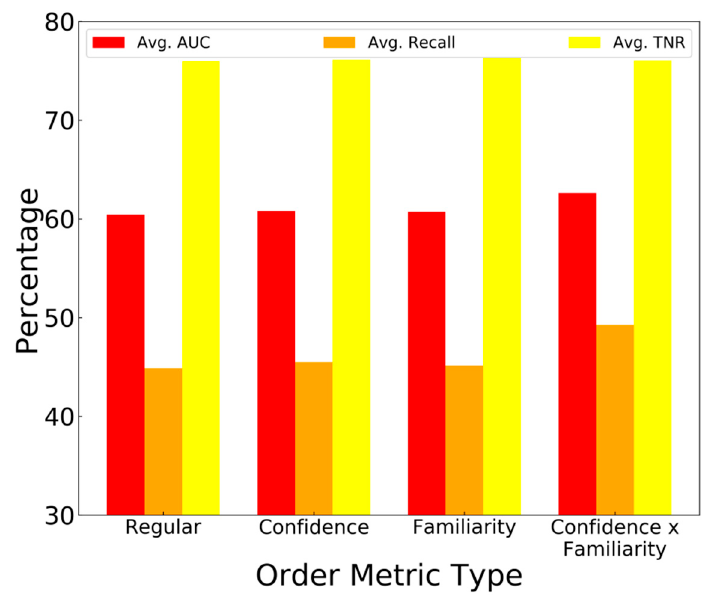
Figure 15. Averaged classification results using different order metrics for KNN-Imputation.